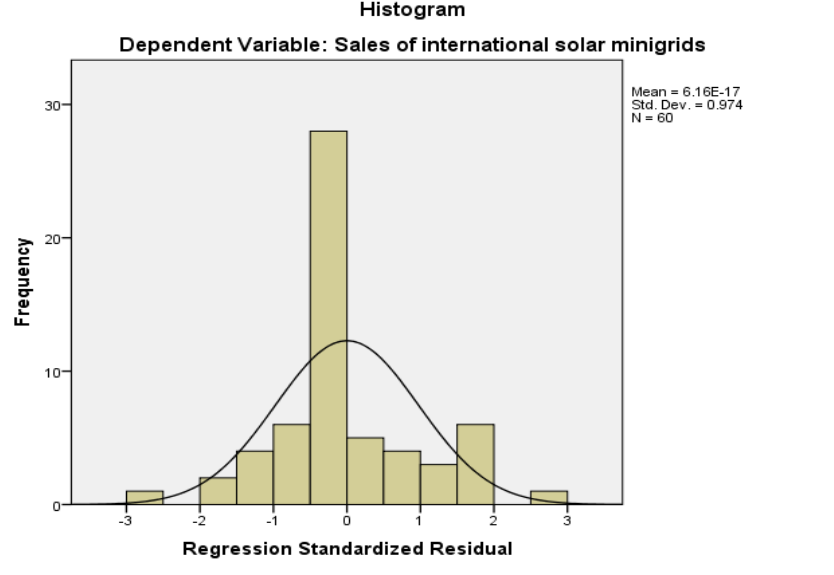
Figure 3: Variance Inflation Factor (VIF) Values; Source: Filed Data 2021 Results in Figure 3 revealed no multicollinearity between independent variables. Indexes of tolerance stood at 0.771 to 0.701. Also, Variance Inflation Factor (VIF) stood at below 1.428. Tolerance is expressed as total inconsistency of designated Independent Variables (IV) that are not clarified by additional IV. VIF is the inverse of tolerance value (Hair et.al. 2010:227). This is from the individual independent variable as 1 - R2. Tolerance value from 0 to 1, means it is low, hence there is the existence of Multicollinearity (Hair et.al. 2010: 227-228). Hair et.al (2010: 227) proposes a 0.10 tolerance value which is equivalent to a VIF of 10 to be a normal cut-off